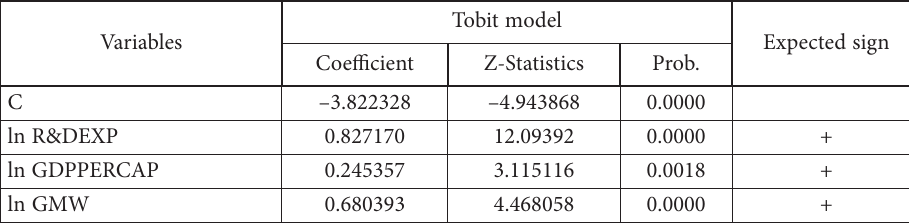
Table 5. Determinants of RMU – summary of the Tobit